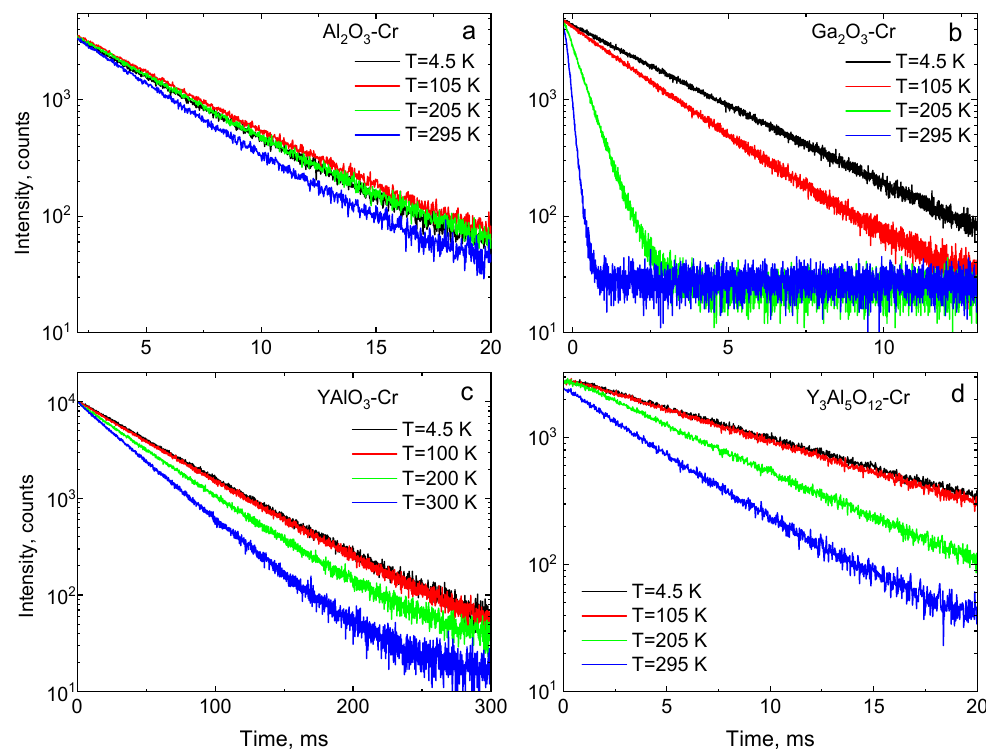
Figure 7. The luminescence decay curves of Cr 3 + emissions in Al 2 O 3 -Cr ( a ), Ga 2 O 3 -Cr ( b ), YAlO 3 -Cr ( c ), and Y 3 Al 5 O 12 -Cr ( d ).